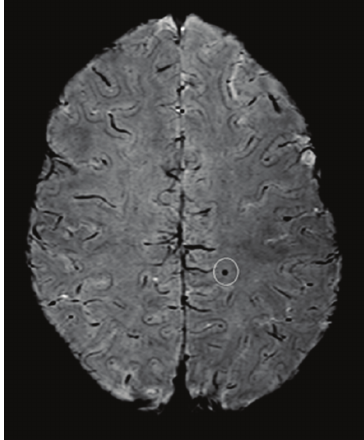
Figure 1: Hemosiderin detected with multiecho susceptibility weighted imaging using a 3 Tesla scanner. Multiecho SWI image (Philips Achieva 3T; 5 echoes; voxel size = 0.32 × 0.32 × 0.75 mm 3 ). Courtesy of Alexander Rauscher, Ph.D., UBC